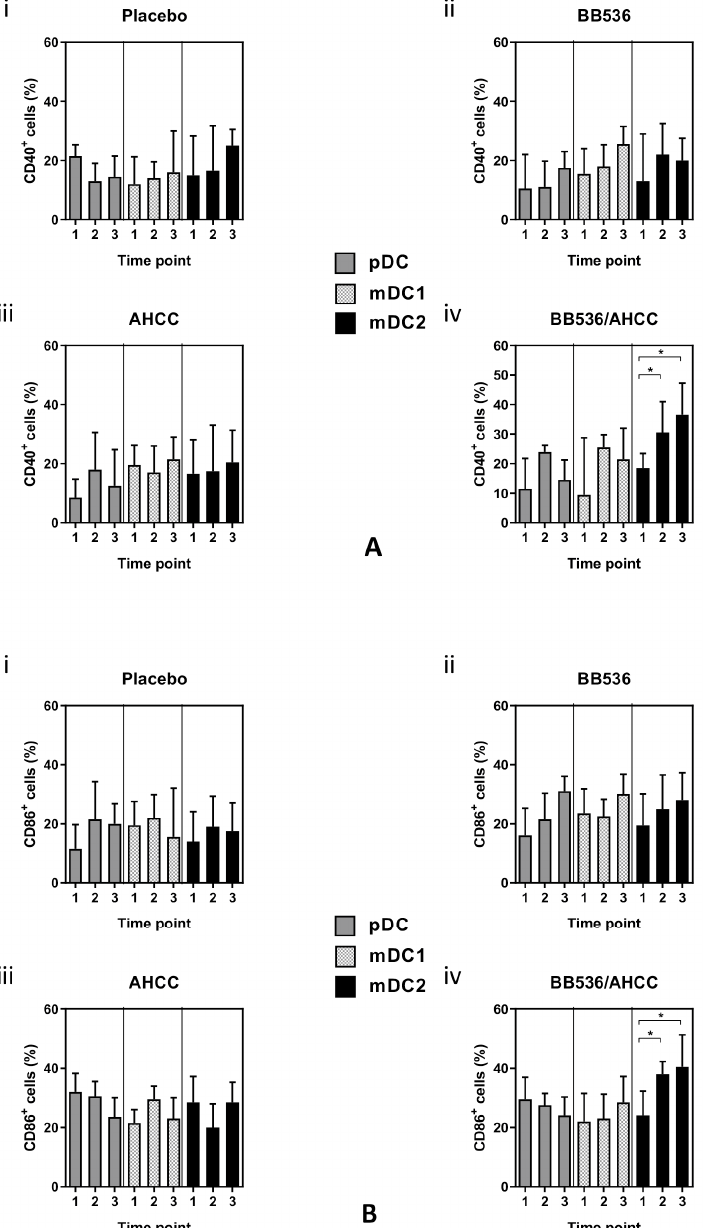
Figure 4. ( A ) Cell surface co-stimulatory marker CD40 expression on DC subsets as percentage of total DCs. ( B ) Cell surface co-stimulatory marker CD86 expression on DC subsets as percentage of total DCs. Values represent mean (SEM). Significance calculated using the Student t test (paired). BB536: Bifidobacterium longum ; AHCC ® : a standardized extract of cultured Lentinula edodes mycelia; *: p < 0.05. Time points: 1—pretreatment, 2—after 7 days of placebo (i)/BB536 (ii)/AHCC ® (iii)/both (iv), 3 – after an additional 5 days of placebo (i)/BB536 (ii)/AHCC ® (iii)/both (iv) + azithromycin (day 13).